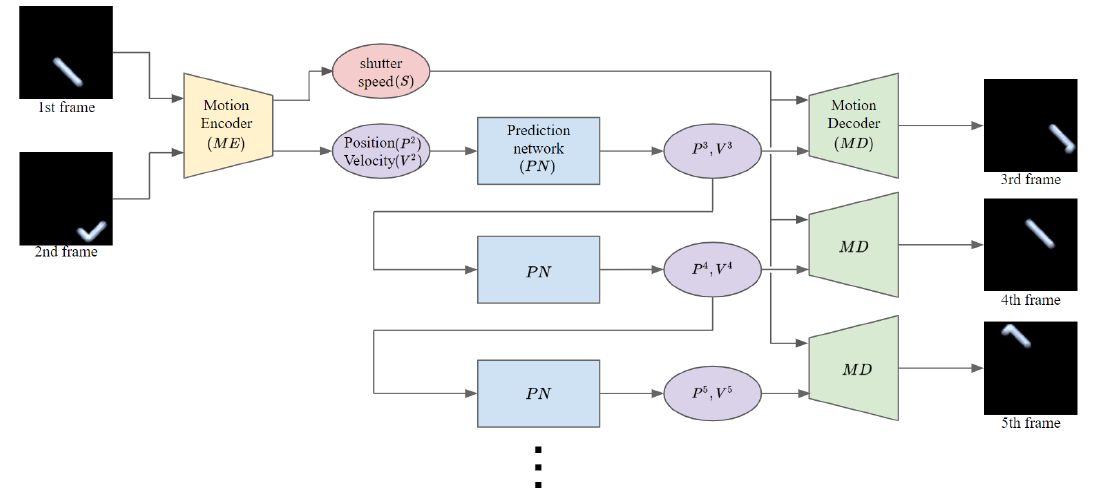
Figure 3. Overview of the proposed